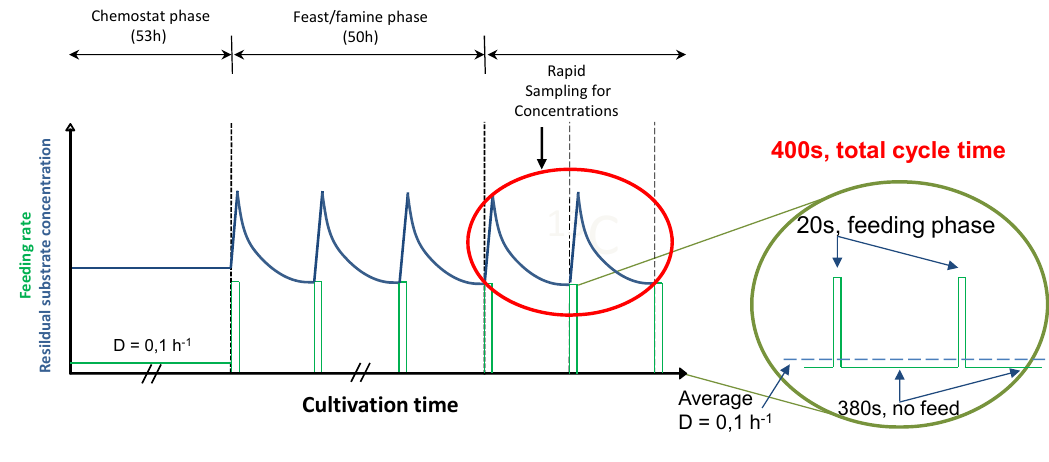
Figure 10. Profile of the experimental feeding and the resulting substrate concentration during the chemostat and the feast/famine phase. The feeding rate is represented by the solid green